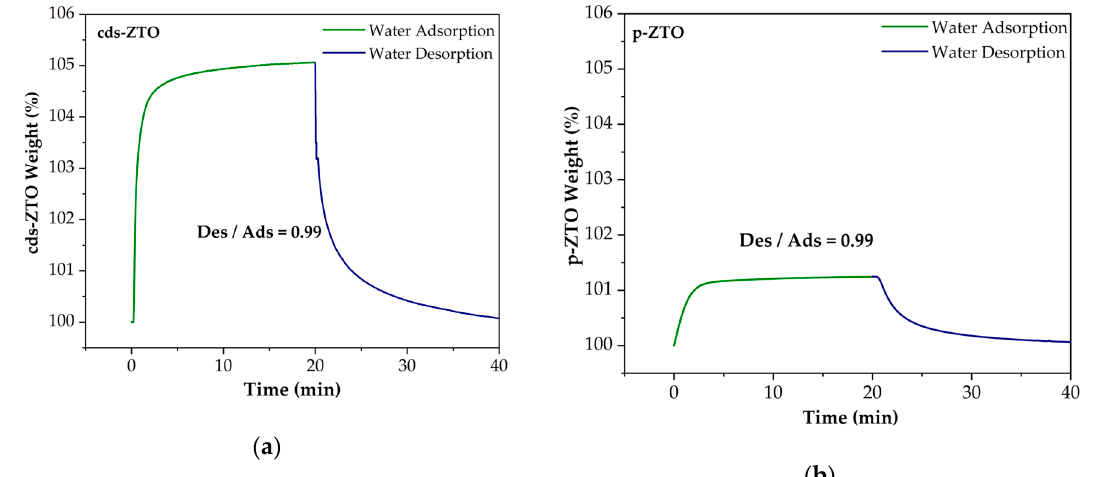
Figure 9. Adsorption–desorption isotherms of H 2 O on ( a ) cds-ZTO, ( b ) p-ZTO.